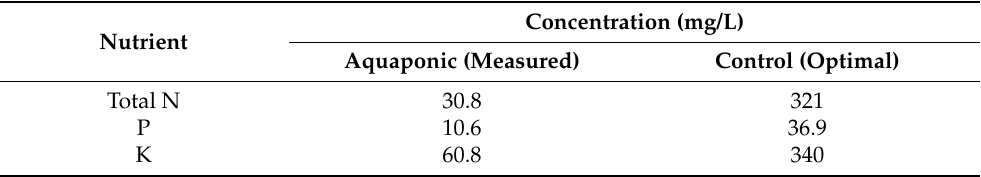
Table 2. Average concentrations of N, P, and K in water of aquaponic and control systems throughout the growth